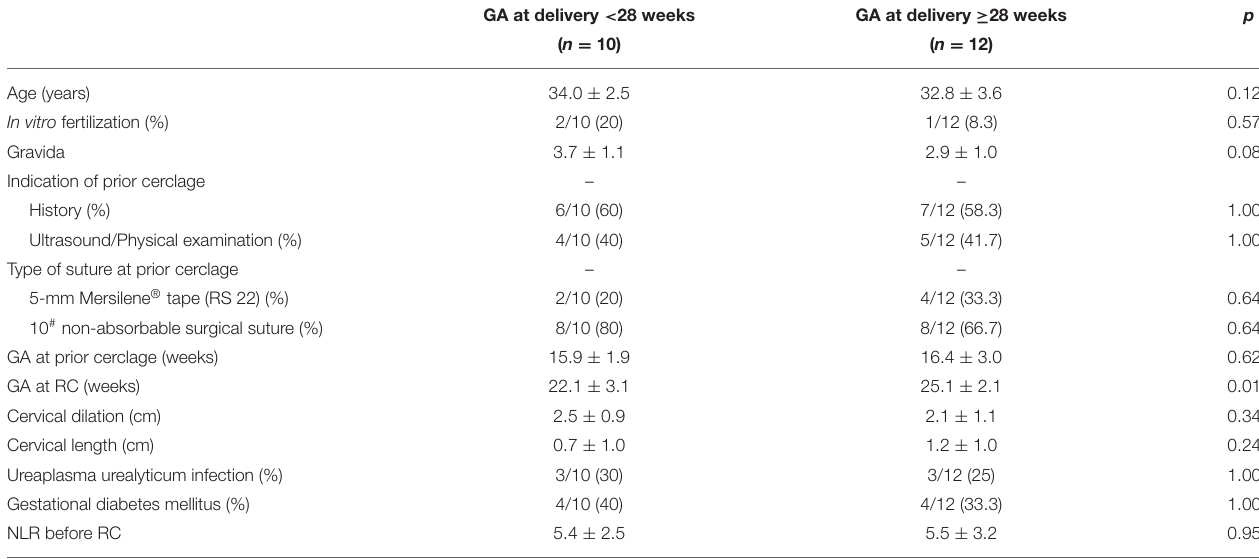
TABLE 2 | Comparison of clinical characteristics among patients with singleton pregnancies between GA at delivery < 28 weeks and ≥ 28 weeks.